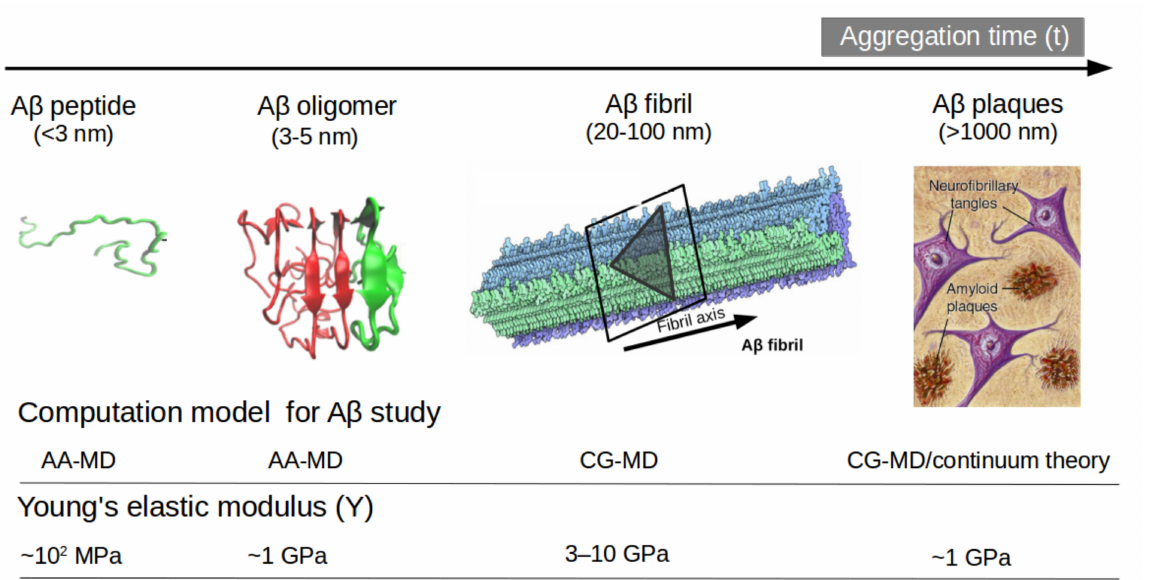
Figure 2. Representation of A β structures during aggregation: free A β peptide, oligomers, fibrils and plaques. Typical lengths are given for peptide (<3 nm), oligomers (3–5 nm) and fibrils (20–100 nm). All-atom MD (AA-MD), coarse-grained MD (CG-MD) and continuum models have been employed to unveil the mechanical stability for each structure. Young modulus (Y) defined by the ratio of applied tensile stress to a given strain provides an idea of the elastic regime. Y values for each structure is taken from ref (50 and 51). Some images are modified with permission of BrightFocus